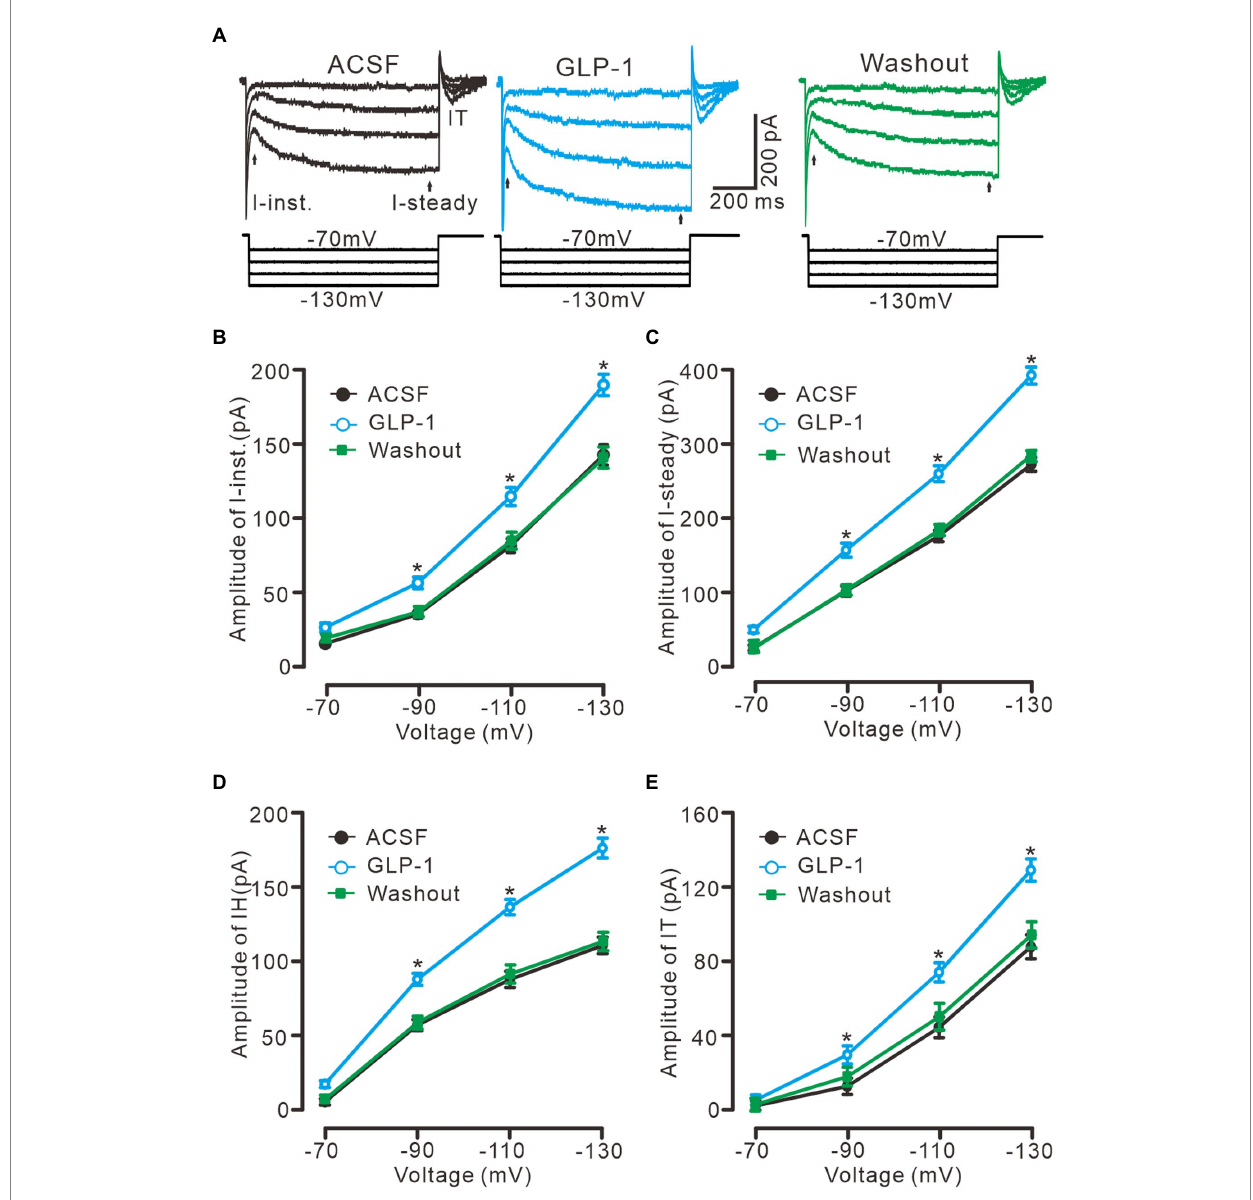
FIGURE 5 GLP-1 enhanced IH currents in cerebellar PCs. (A) Under voltage-clamp recording mode (V hold = − 60 mV), the representative traces showing membrane current traces elicited by a set of hyperpolarizing voltage step (20 mV decrements, 1 s) during treatments of ACSF, GLP-1 (100 nM) and washout. (B,C) The mean (± S.E.M) amplitude of the instant current (I-inst. B ) and the steady state current (I-steady, C) evoked by hyperpolarizing steps during treatments with ACSF, GLP-1 and washout. (D,E) The mean (± S.E.M) amplitude of the IH (D) and the tail current (IT; E ) evoked by hyperpolarizing steps during each treatment. * p < 0.05 vs. ACSF, n = 6 cells in each